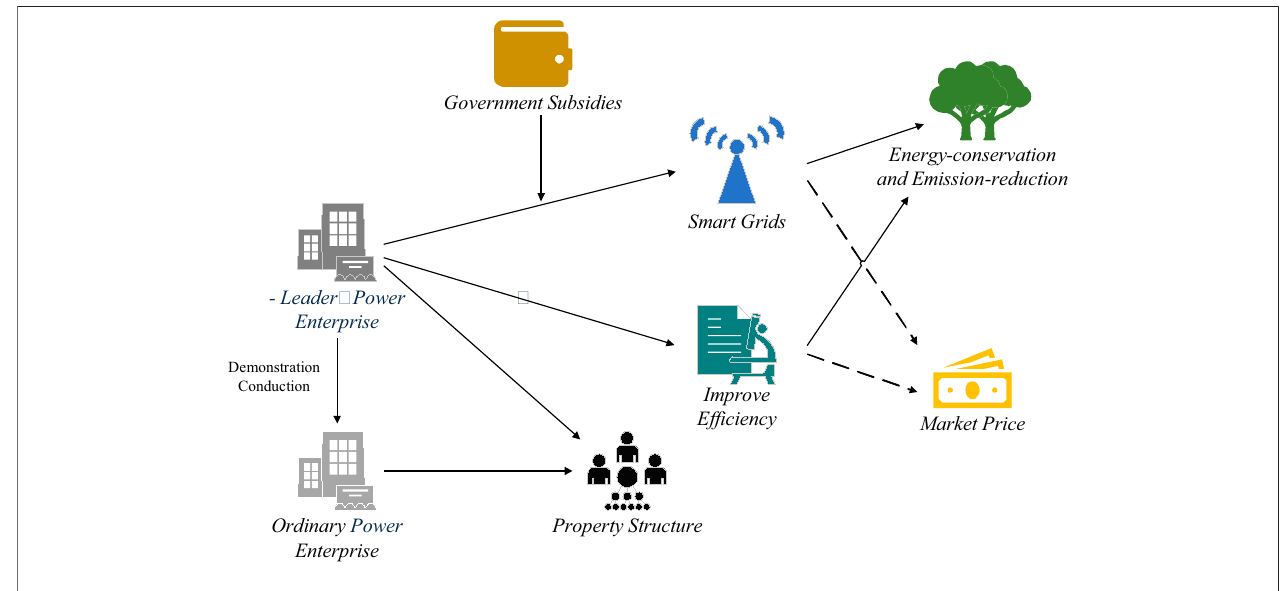
FIGURE 1 | Green transformation path mechanism of power enterprises considering smart